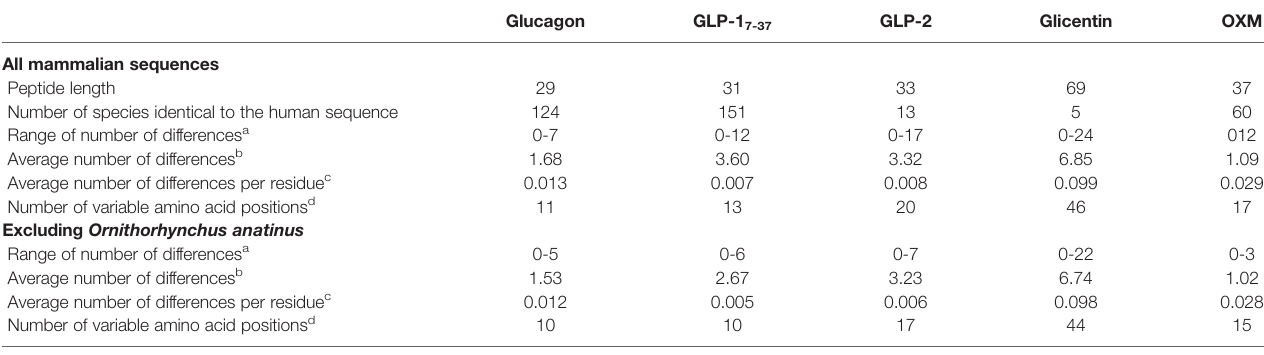
TABLE 2 | Variability of the sequences of mammalian proglucagon-derived